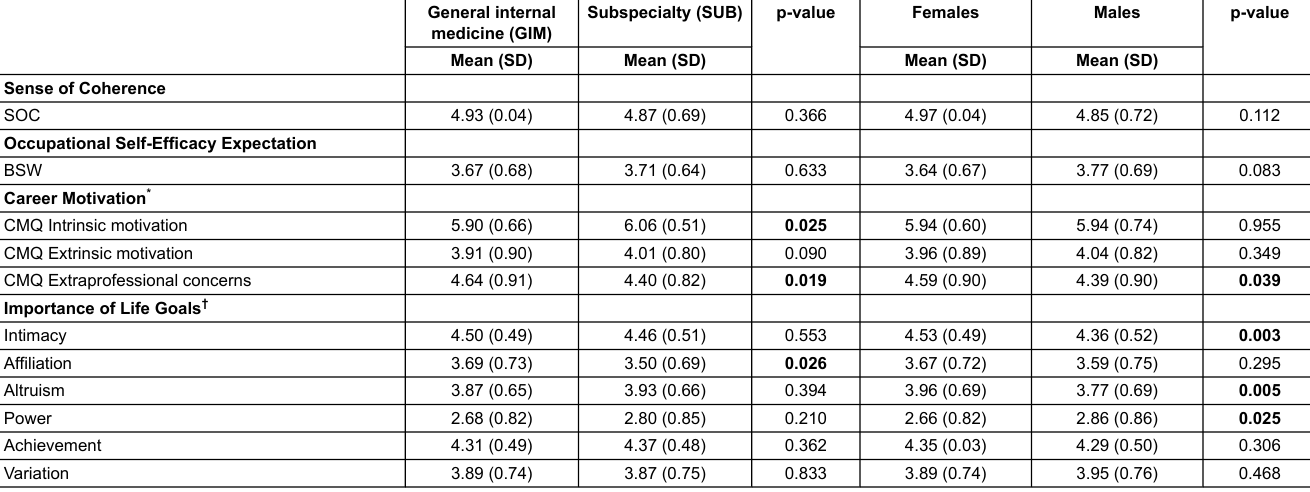
Table 3: Personality and career related factors; importance of life goals by medical specialty (n = 340) and by gender (n = 392) (Buddeberg-Fischer et al. 2006 [8]). The table shows mean scores, standard deviations (SD) and p-values.